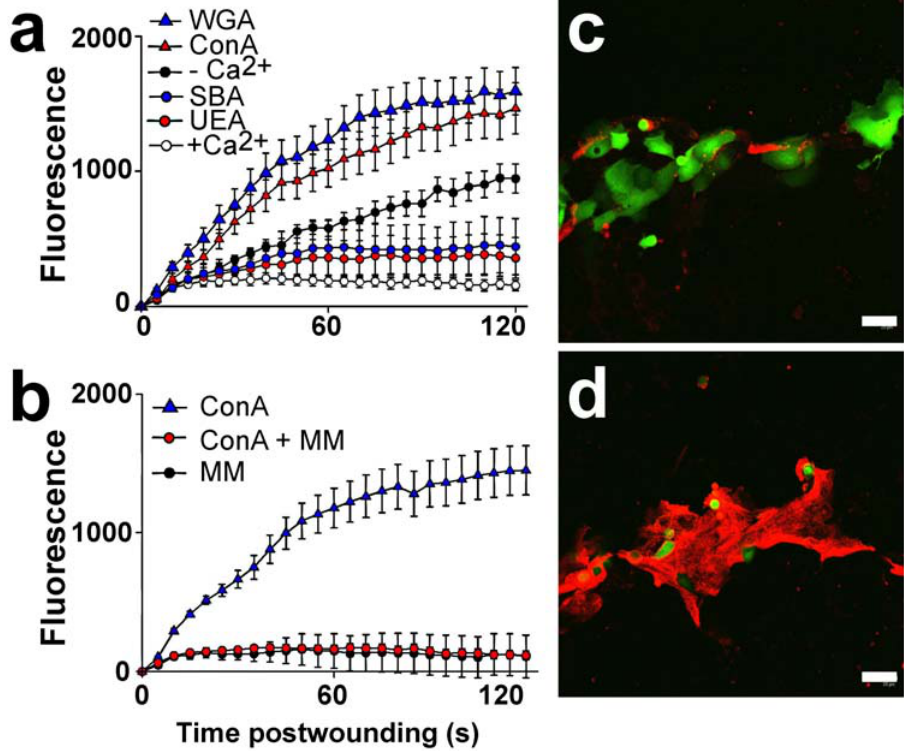
Figure 2. Lectins that bind to the surface of cells potently inhibit membrane repair. (a) Dye entry after laser-induced plasma membrane disruption was evaluated after incubation of cells in the indicated lectins. Dye exclusion from BS-C-1 cells was strikingly inhibited by the lectins Con A (red triangles) and WGA (blue triangles), but not by UEA (red circles) and SBA (blue circles). Positive controls (empty circles) were wounded in PBS containing 1.5 mM Ca 2 + , the vehicle for all lectins; negative controls (black circles) were wounded in PBS minus added Ca 2 + (n=18, 6 S.E.M.).(b) Inhibition was prevented by the addition of competitive sugar, methyl- a -D-mannopyranoside ( MM ) in the case of ConA. (n=18, 6 S.E.M.). (c) Control, untreated SSM cell cultures were scratched to induce membrane disruptions along the injury site in the presence of FDx (10,000 MW, green), a marker of cells that suffer and repair a membrane disruption. They were then washed and FM 4-64 (red) was added (3 min later) to the medium: it acts under these conditions as a marker for cells that fail to reseal. The untreated cells along this scratch site are predominantly labeled with FDx, indicating successful repair of plasma membrane disruptions. (d) By contrast, WGA-treated cells lining this scratch site were predominantly labeled with FM